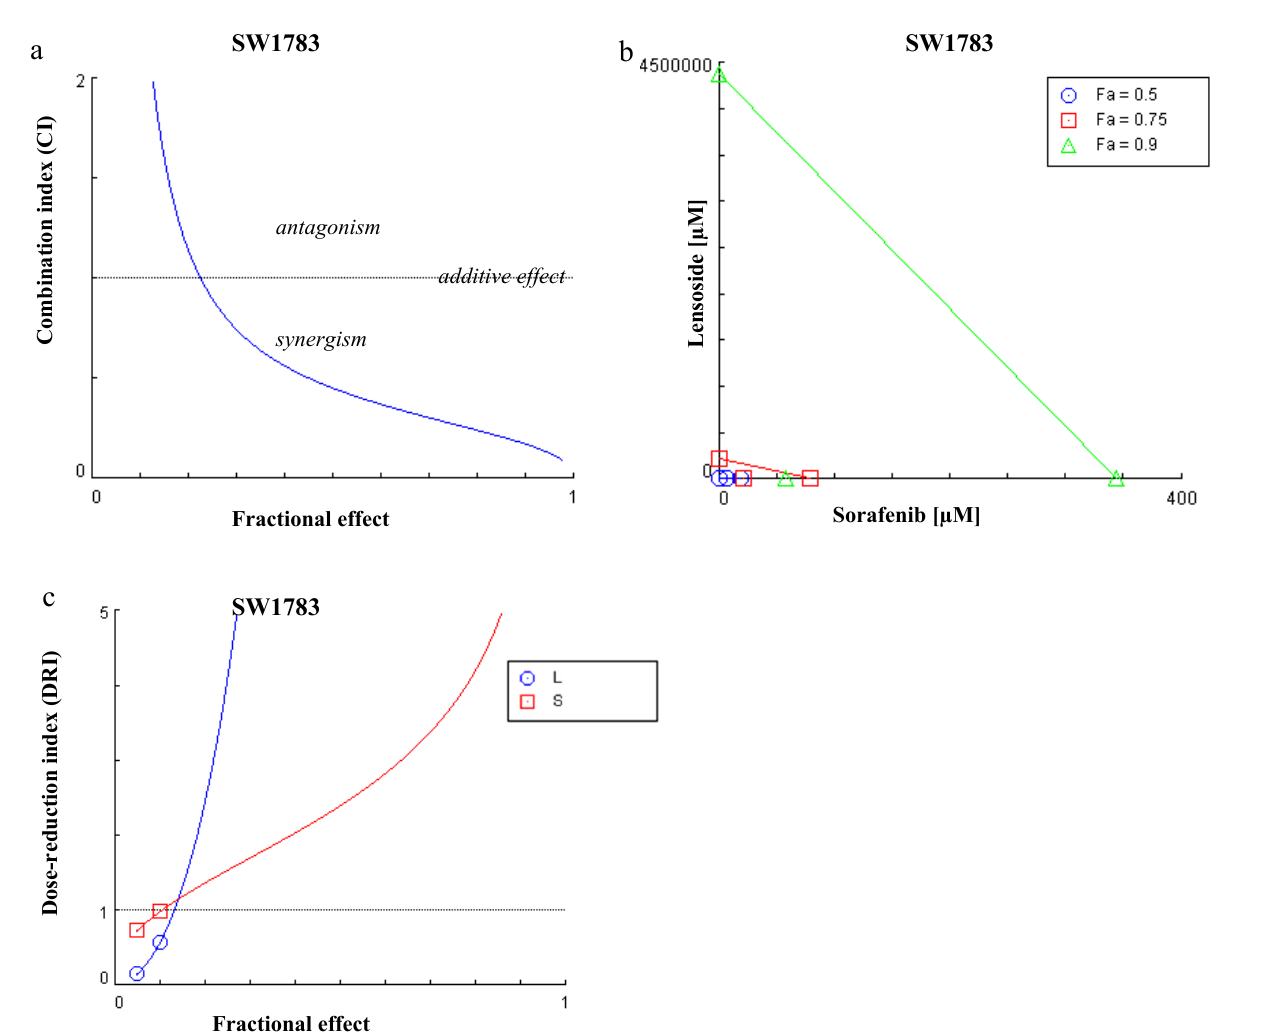
Figure A5. Lensoside A β (L) and sorafenib (S) combination treatment. ( a ) Combination index (CI) plot: The combination index is plotted as a function of Fa (fractional effect). ( b ) Isobologram for combination: isobologram at IC50, IC75, and IC90. ( c ) the F a -DRI (dose reduction index) plot (Chou-Martin plot). Combination index (CI) and dose reduction index (DRI) were calculated according to the method of Chou and Talalay using the Compusyn software. CI < 1, CI = 1 and CI > 1 indicate synergistic effect, additive effect, and antagonistic effect, respectively. The combination of lensoside A β with sorafenib in the SW1783 line showed a synergistic effect. It was stronger when the higher dose was used, which is extremely important in anti-cancer therapy (for IC97, CI = 0.1). Moreover, the combination treatment significantly reduced the doses of both drugs (DRI > 1), which in a single application would have to be higher to obtain the same effect. Therefore, in the combined therapy of lensoside A β with sorafenib, the lowest doses that gave the best effect were used. These were the same as for monotherapy and the final concentrations of sorafenib and lensoside A β were 1 µM and 50 µM, respectively.